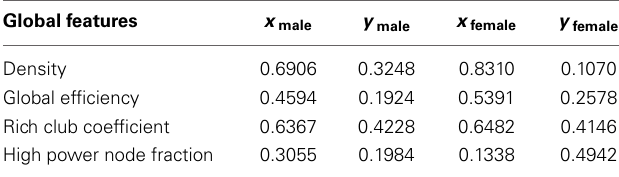
Table 4 | Correlations of the global features of the networks with the x and y dimensions of the projected spaces of the male and female